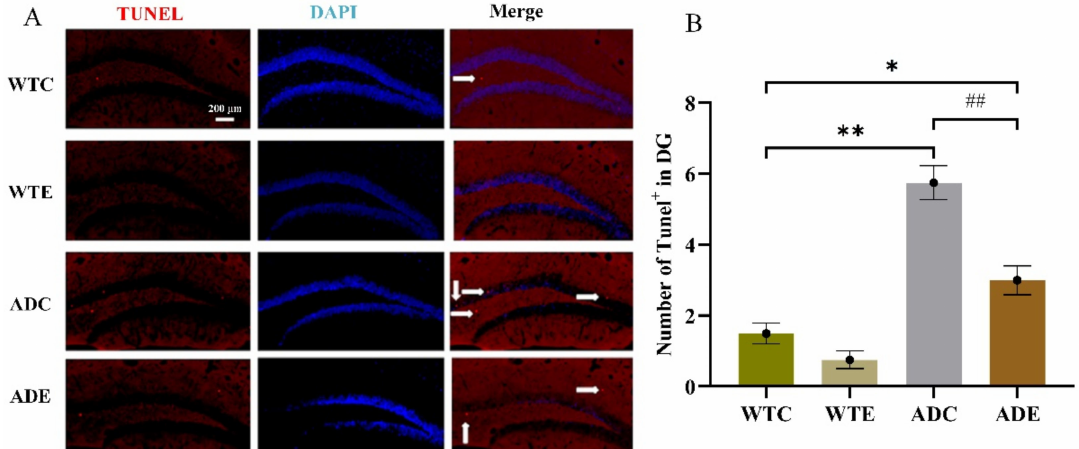
Figure A1. Effect of treadmill exercise on cell apoptosis in mice. ( A ) TUNEL staining results in hippocampus. ( B ) The number of cell apoptosis in hippocampus. n = 4 for each group. * p < 0.05, ** p < 0.01 compared with WTC. ## p < 0.01 compared with ADC. The arrows point to the apoptosis